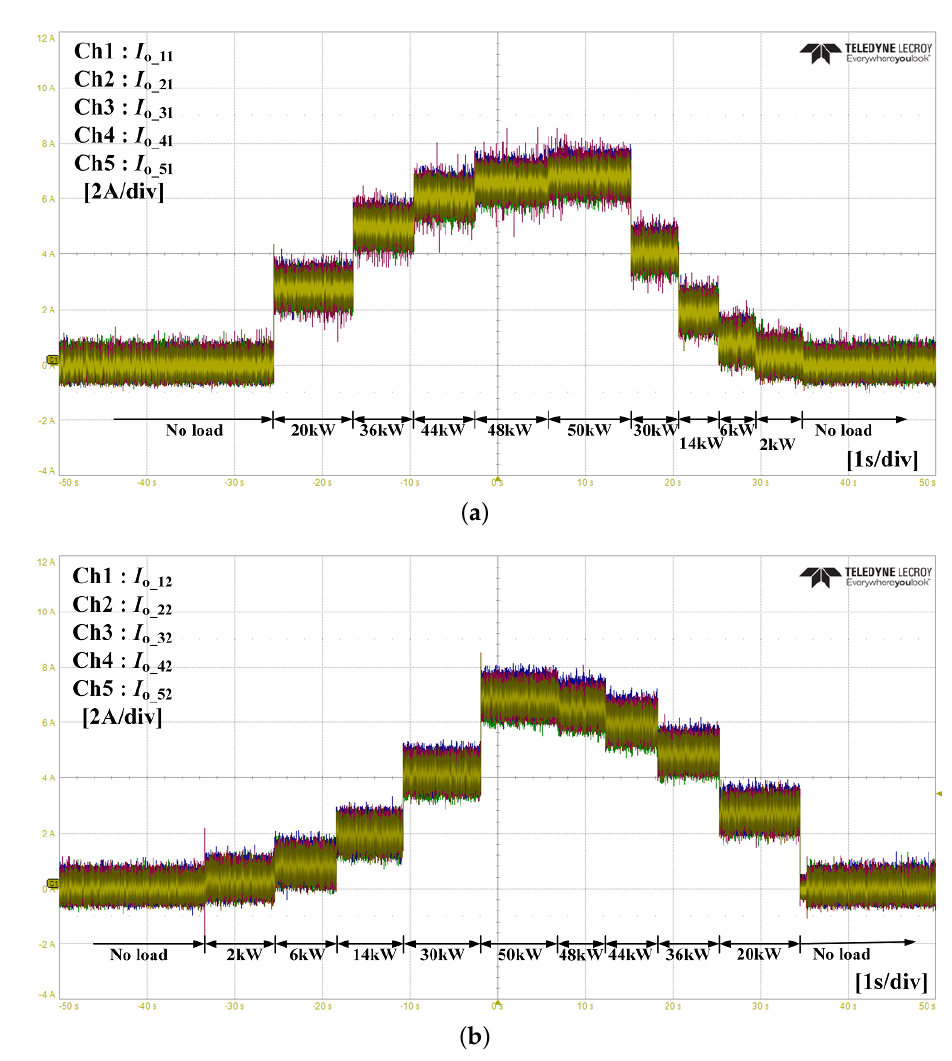
Figure 18. Current sharing waveforms: ( a ) output currents corresponding to Port 1; ( b ) output currents corresponding to Port